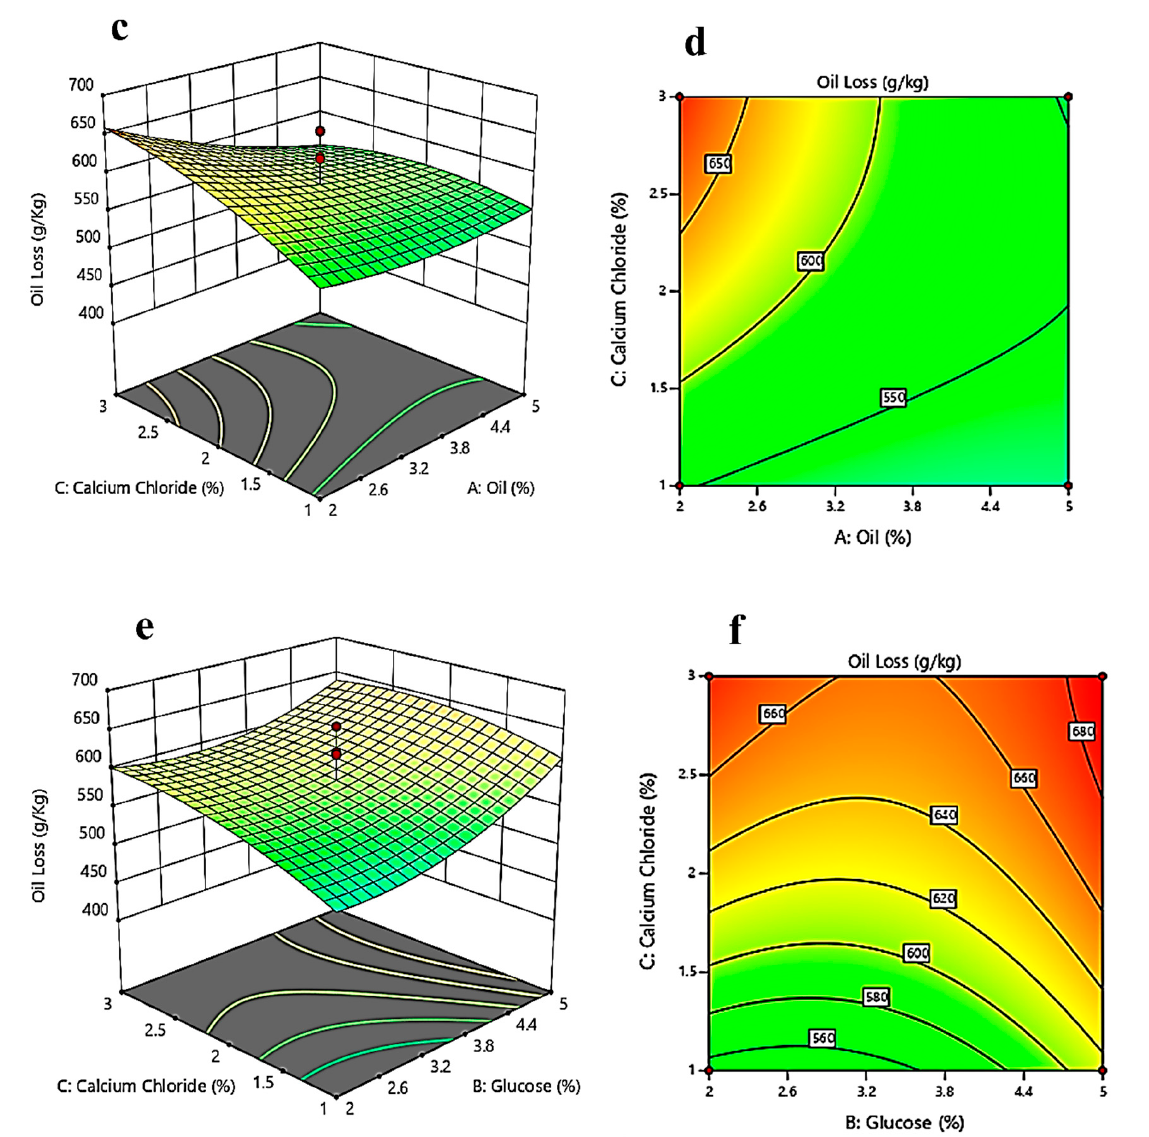
Figure 5. Three-dimensional surface optimization of ( a ) oil (%), and glucose (%); ( c ) oil (%), and calcium chloride (%); ( e ) glucose (%), and calcium chloride (%) on the oil loss (g/kg). Contour plots showing the effect of ( b ) oil (%), and glucose (%); ( d ) oil (%), and calcium chloride (%); ( f ) glucose (%), and calcium chloride (%) on the oil loss (g/kg).